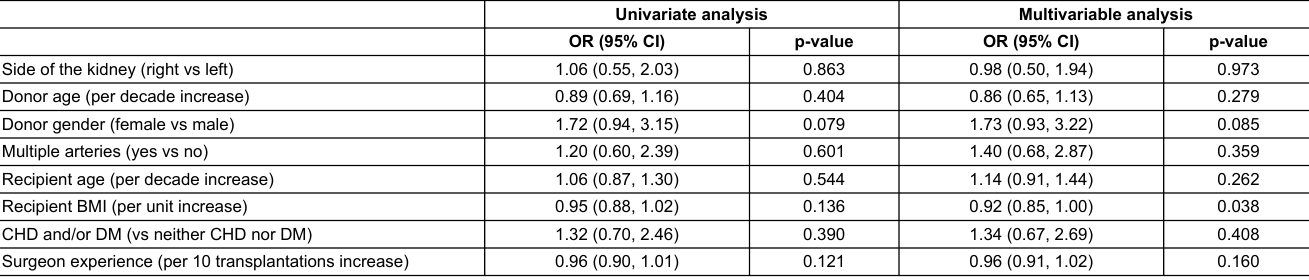
Table 3: Logistic model for surgical complications Clavien-Dindo ≥3 (n =